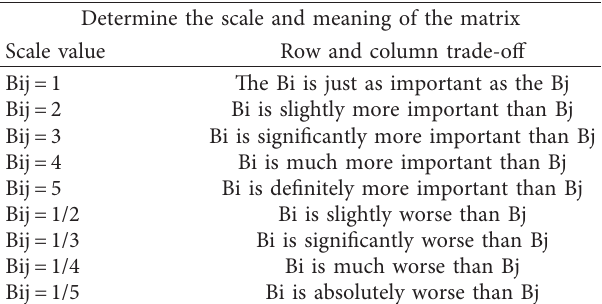
Table 2: Usage of AHP as the significance comparison scale of each